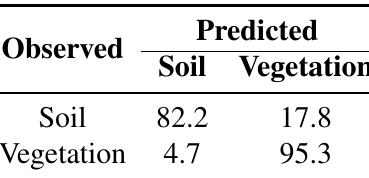
Table 1. Binary logistic regression values showing the percentages of classification using light detection and ranging (LIDAR) height and reflection values.